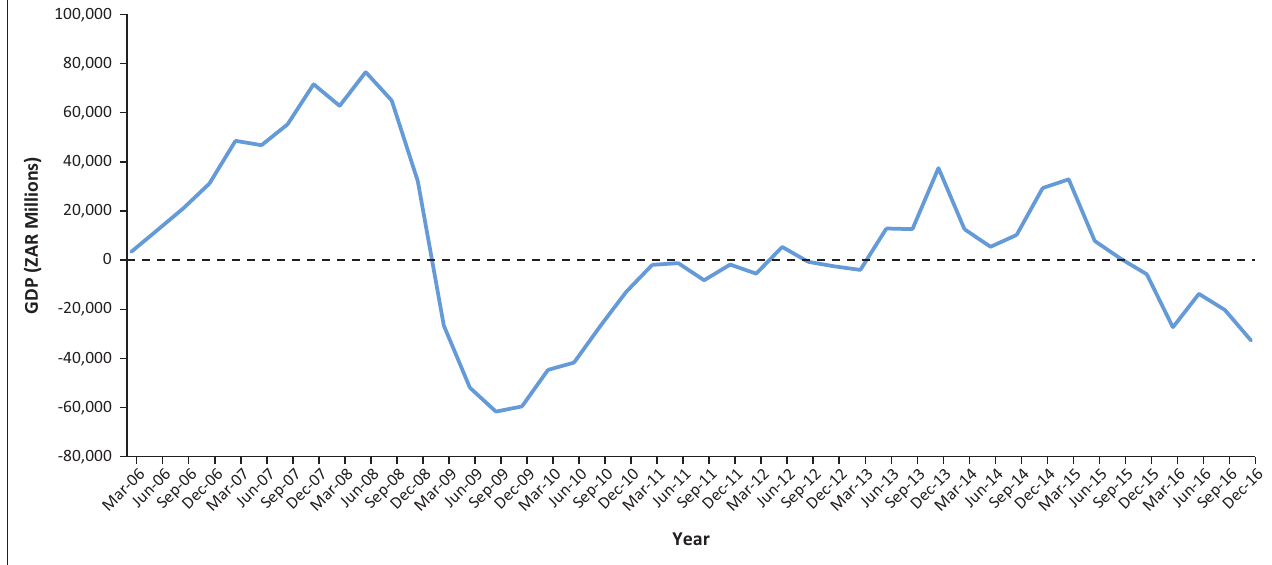
FIGURE 3: South African business